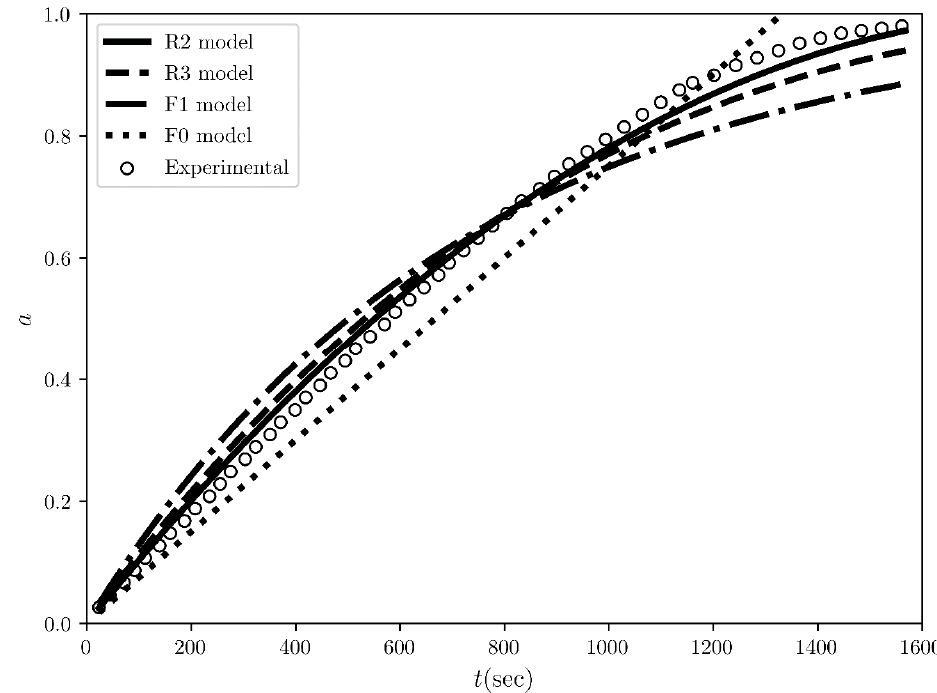
Figure 6. The conversion fraction time evolution regarding the desolvation of the methanol solvates of ciclesonide at 115 °C. The scatter plots represent the rates evaluated from the experimental conversion fraction measured by L. Zhou et al. [3] while the solid and dashed black lines represent the straight line fits for the “best” four models ranked by COMF, i.e., R2, R3, F1 and F0 models.